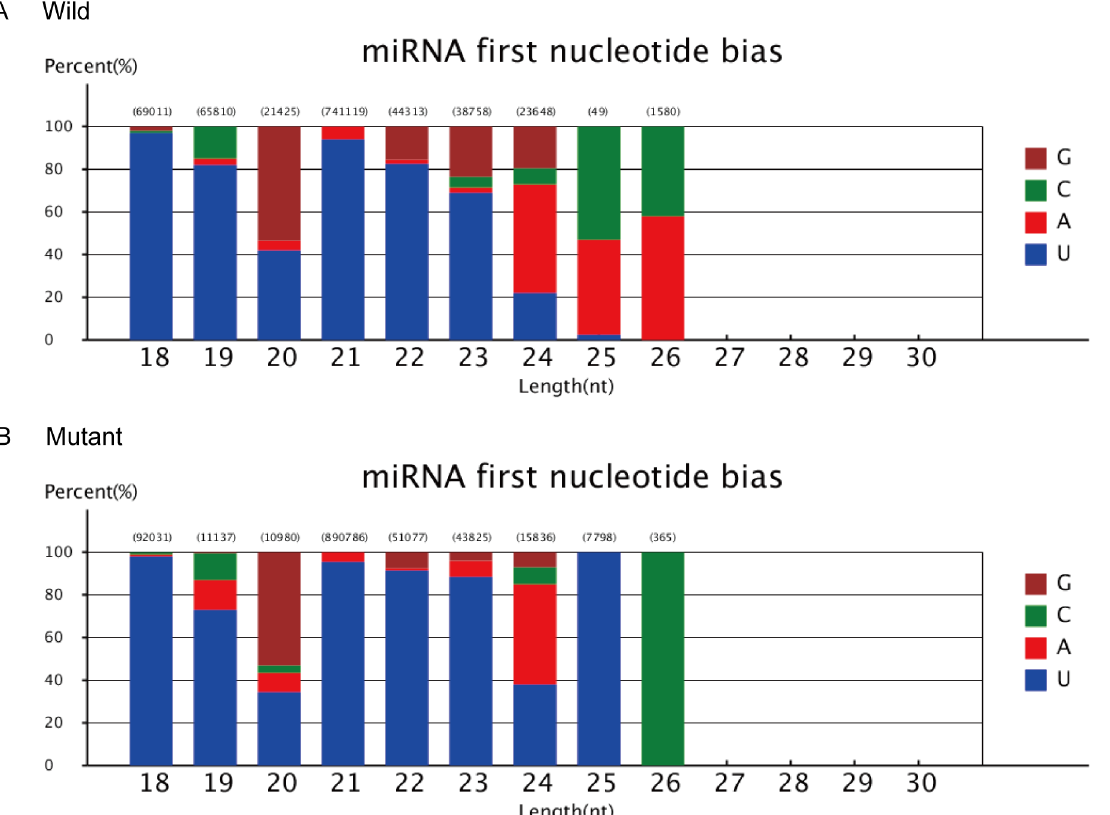
Fig 3. Distribution of miRNA first nucleotide bias. A) wild strain; B) mutant strain.